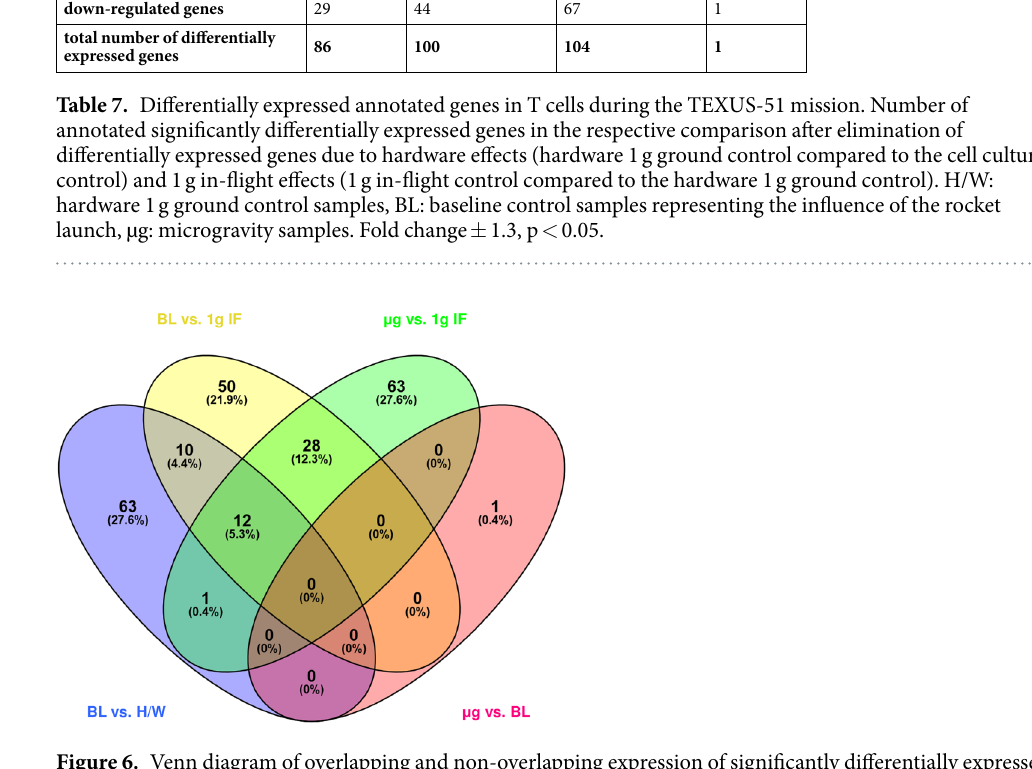
Figure 6. Venn diagram of overlapping and non-overlapping expression of significantly differentially expressed genes due to altered gravity conditions during the TEXUS-51 suborbital rocket flight. Hardware ground control (H/W), rocket launch baseline (BL), 1 g in-flight (1 g IF), and microgravity ( µ g). Venn diagram was constructed using Oliveros, J.C. (2007–2015) Venny,